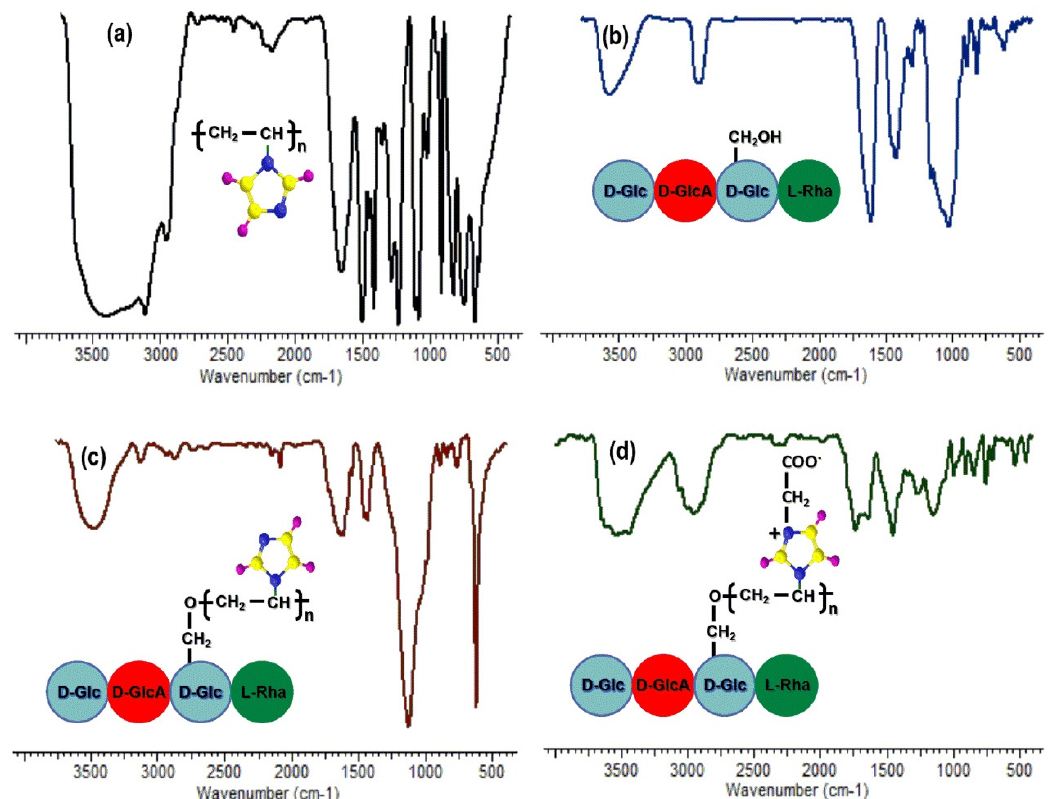
Figure 10. The infrared spectra of PNVI ( a ); GLL ( b ); PG ( c ) and PGB1 samples ( d ).